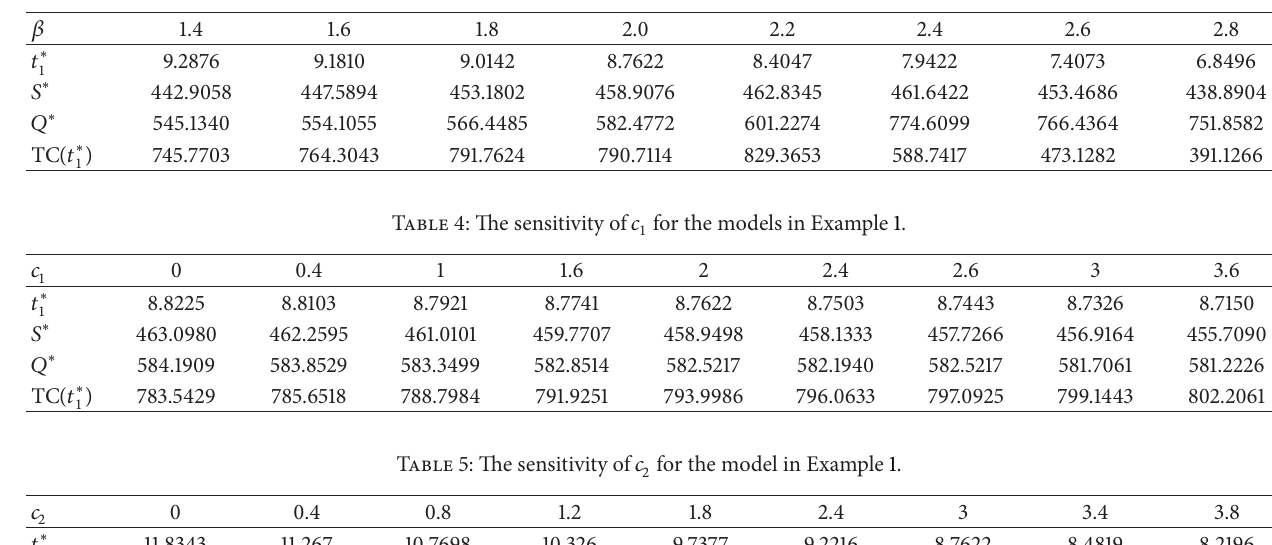
Table 3: The sensitivity of 𝛽 for the models in Example 1.